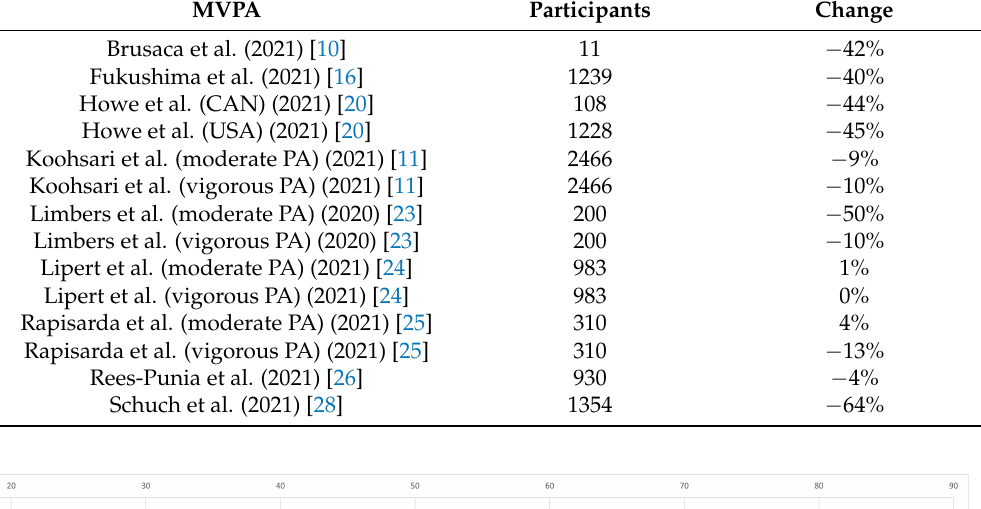
Table 7. Change in moderate to vigorous PA.